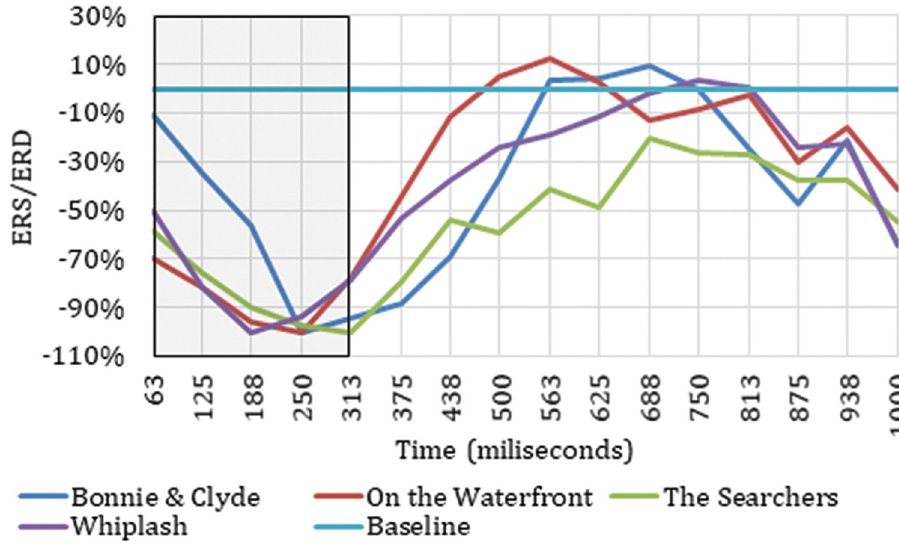
Fig 3. ERD/ERS from the four film excerpts for Pz electrode in high